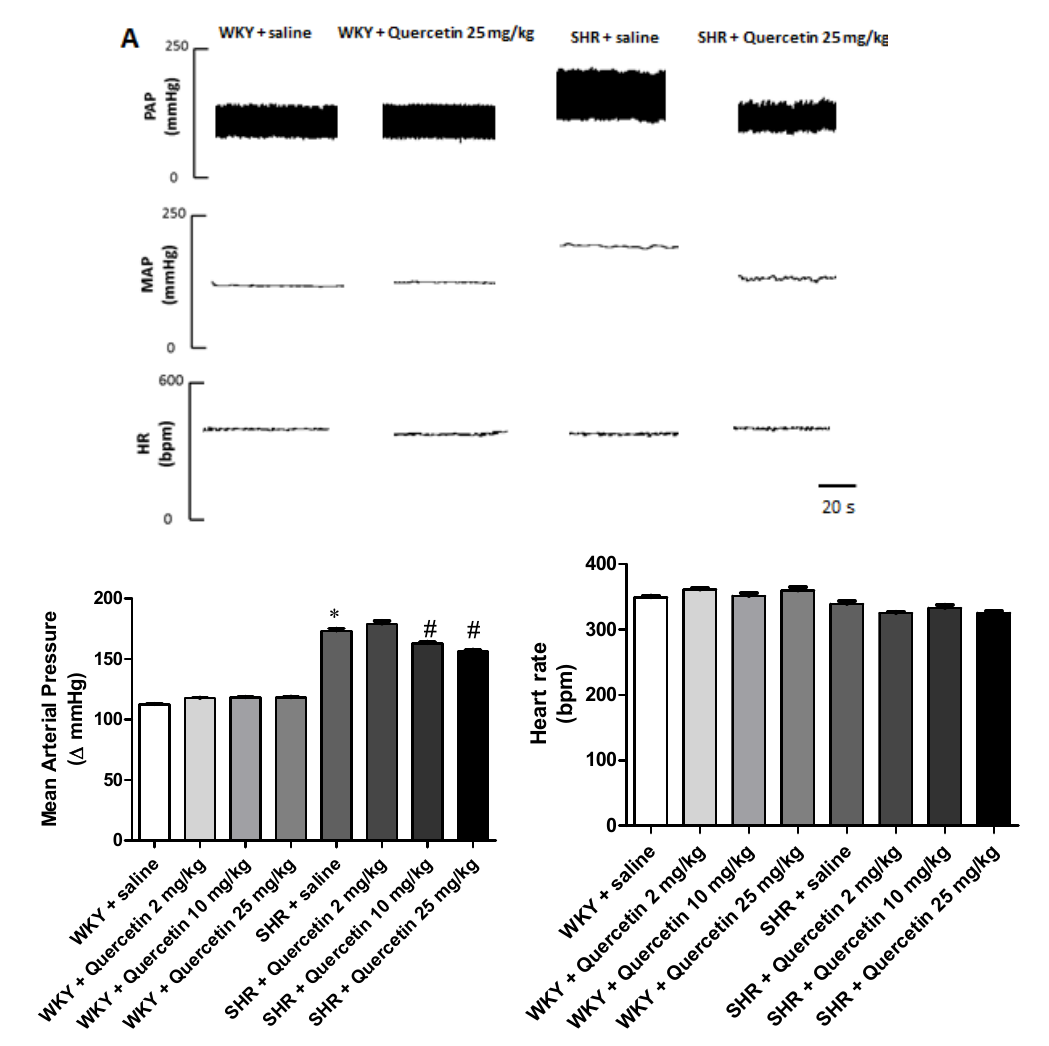
Figure 1. Representative tracings from one rat of each group (WKY + saline, WKY + Quercetin 25 mg/kg; SHR + saline, SHR + Quercetin 25 mg/kg) illustrating the changes in pulse arterial pressure (PAP, mmHg), mean arterial pressure (MAP, mmHg) and heart rate (HR, bpm) ( A ); Effects of Queretin on mean arterial pressure and heart rate ( B ). * p < 0.05, when compared to WKY + saline group and # p < 0.05 when compared to SHR + saline